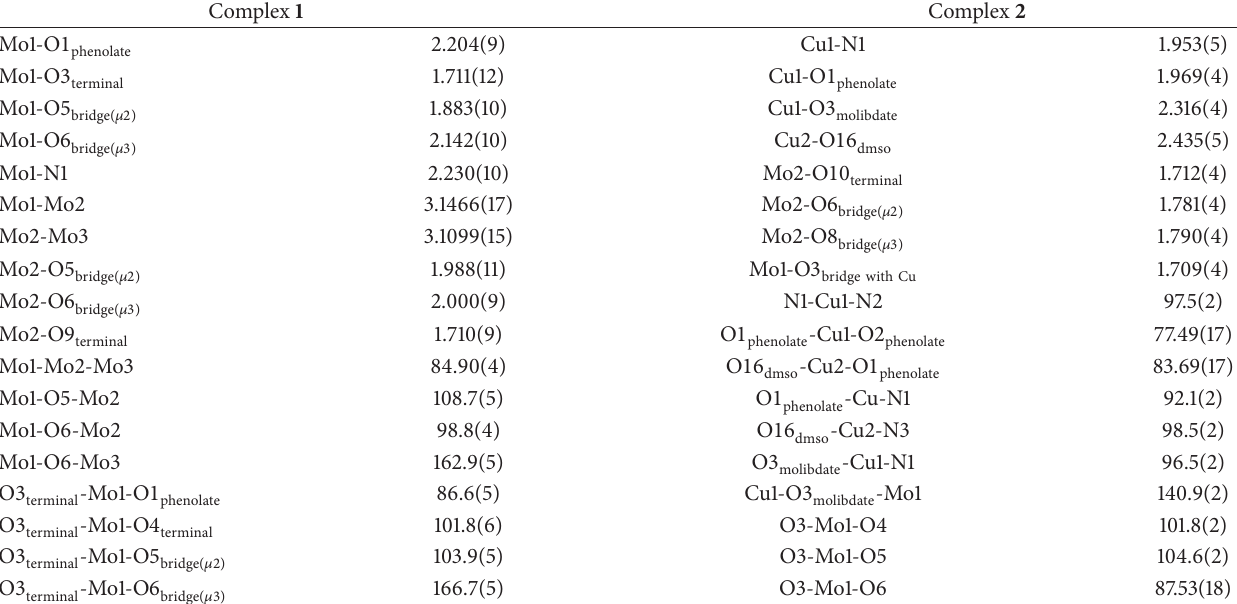
Table 1: Selected bond lengths/˚A and angles/ ∘ for complexes 1 and 2